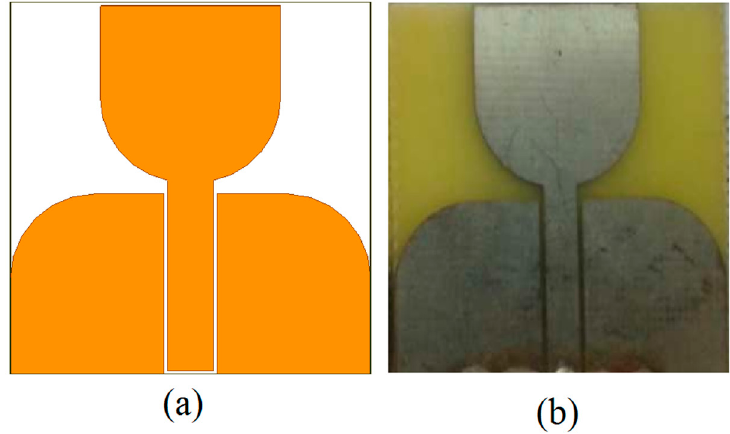
Figure 1. ( a ) Reference UWB antenna and ( b ) prototype of reference UWB Figure 1 . ( a ) Reference UWB antenna and ( b ) prototype of reference UWB antenna.